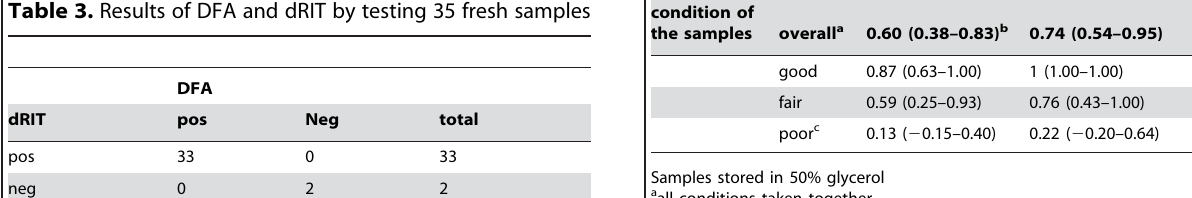
Table 3. Results of DFA and dRIT by testing 35 fresh samples